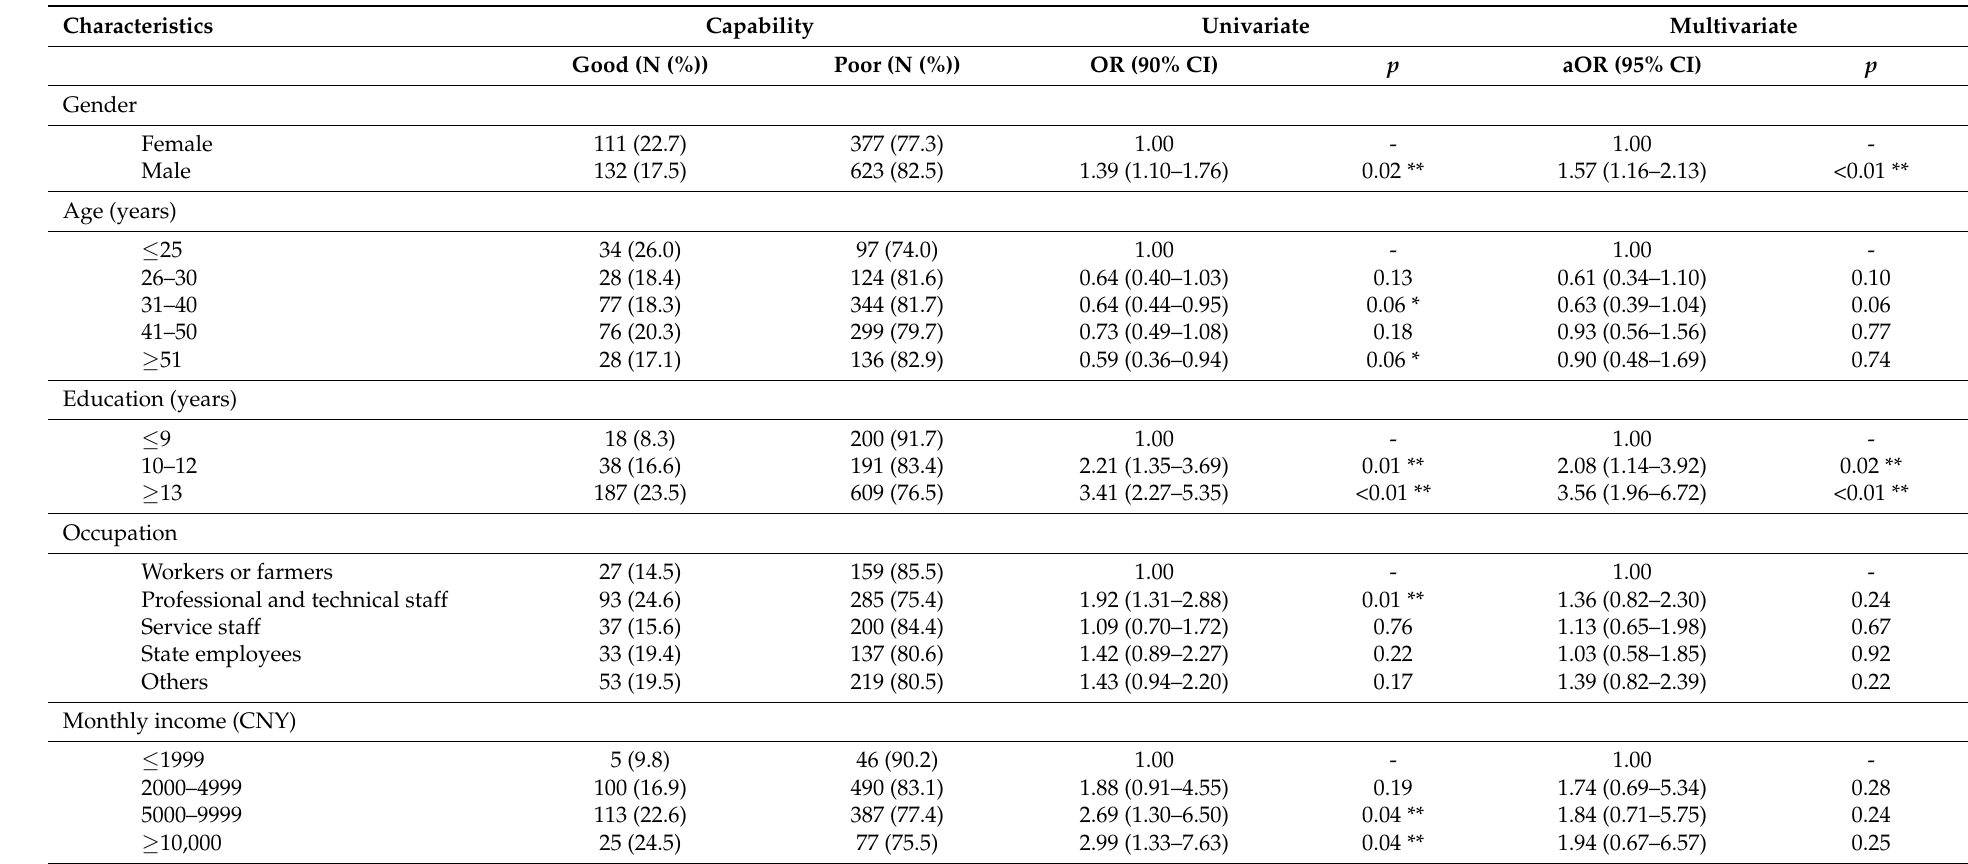
Table 4. Univariate and multiple logistic regression on factors associated with good response capability towards public